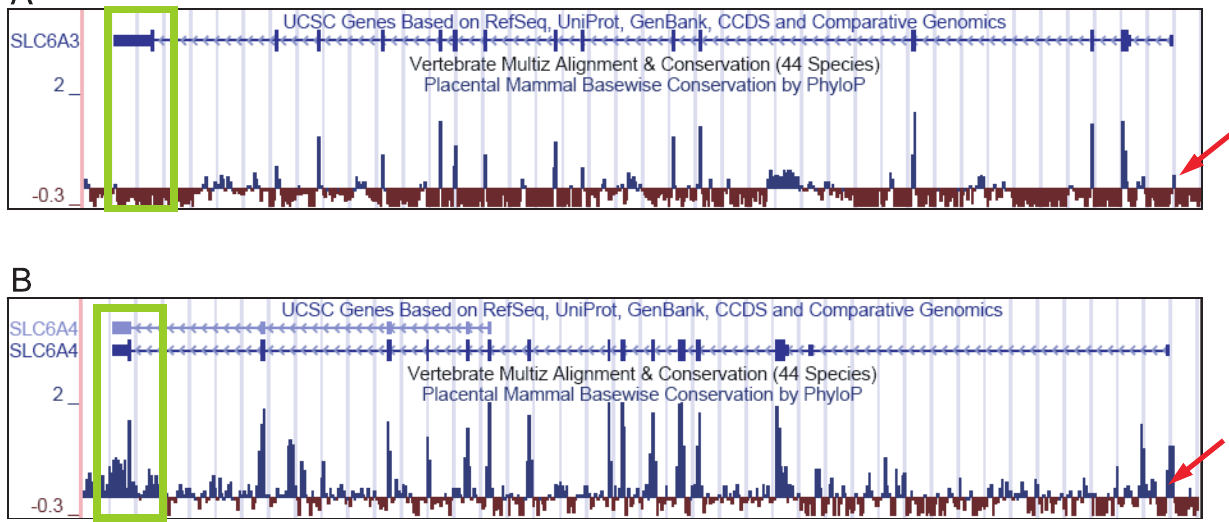
Figure 3. Conservation profiles of the SLC6A3 and the SLC6A4 genomic regions. Conservation tracks of the cognate genes loci shown in UCSC Genome Browser interface. A new Conservation track includes a 44-way vertebrate alignment; the subtracks display phyloP scores (in blue and red). Red arrow points to the promoter regions. The 3 9 -end of the genes framed in the green box. Note that the conservation of the regulatory regions across vertebrate species is evident only in the SLC6A4 locus. In contrast, in the SLC6A3 locus the only visibly prominent is the ‘‘negative’’ phyloP track, which score indicates accelerated evolution of the region.